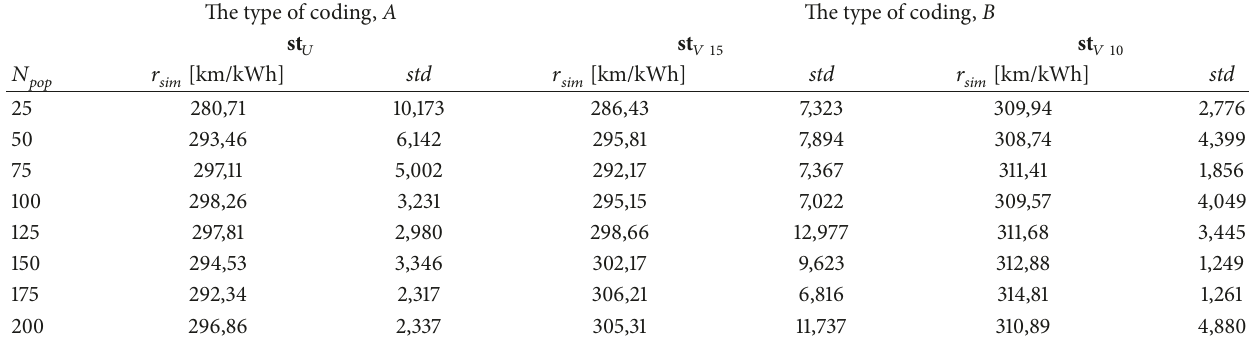
Table 8: The results for route 3.